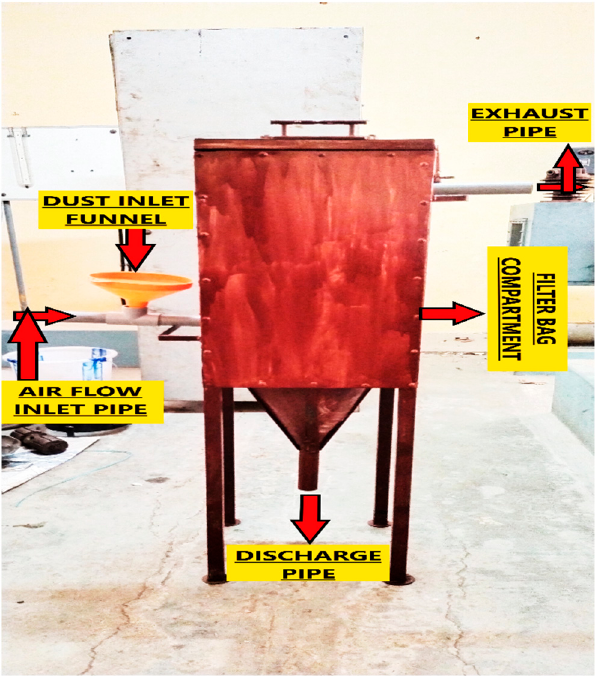
Figure 2. Fabricated bag house filter.